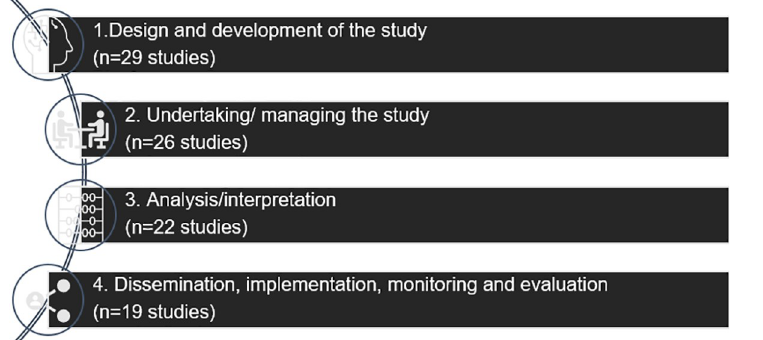
Fig 2. PPIE involvement in the stages of the research